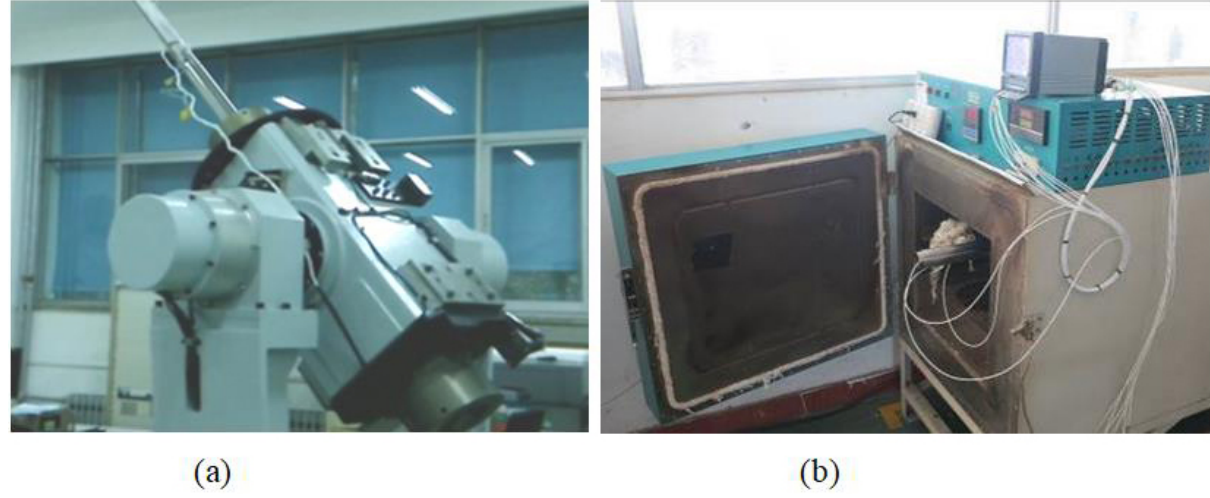
Figure 25. (a) Photo of the experiments on three-axis quadrature calibration bench; (b) photo of the experiments in high-temperature ther- mostat. Table 13. Table of experimental factors and their